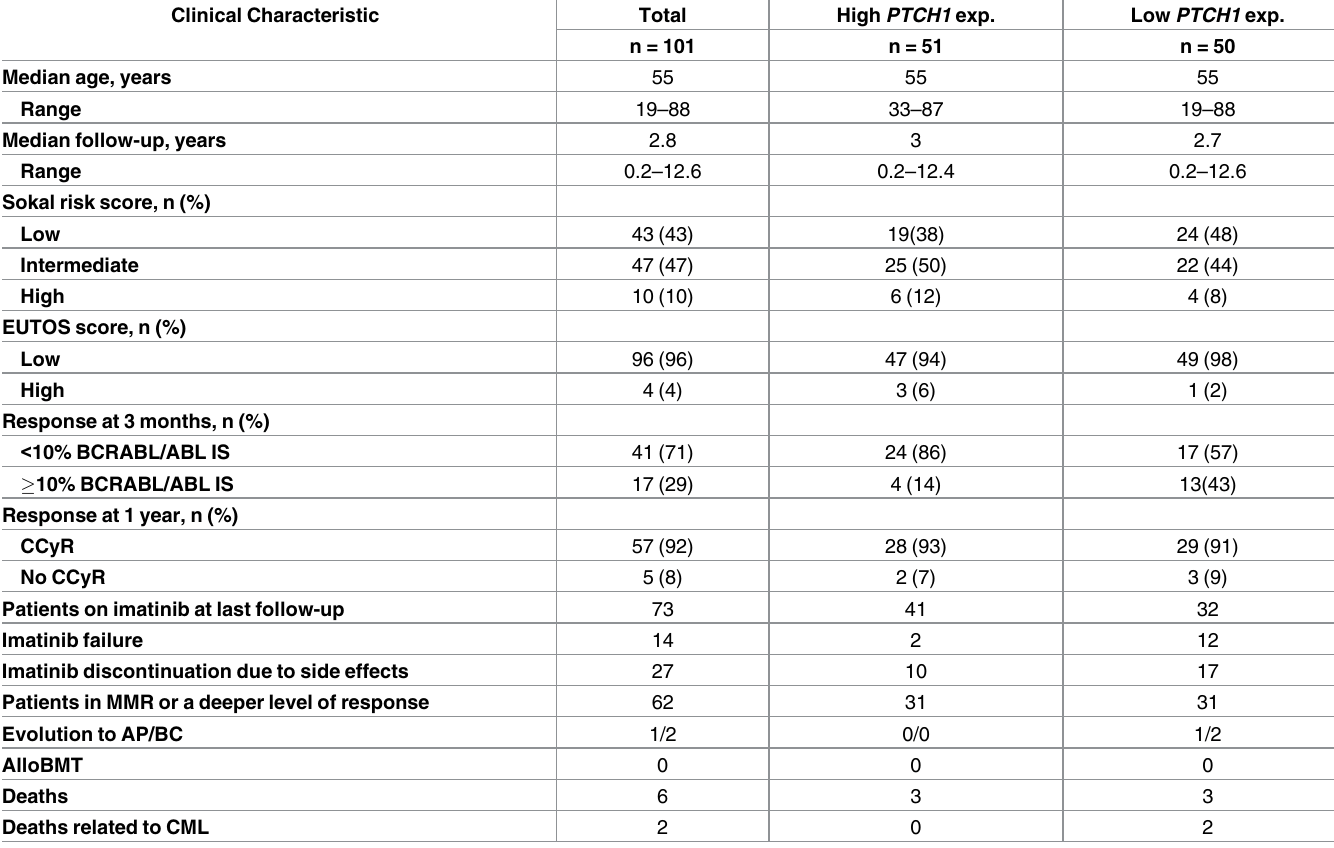
Table 1. Patient